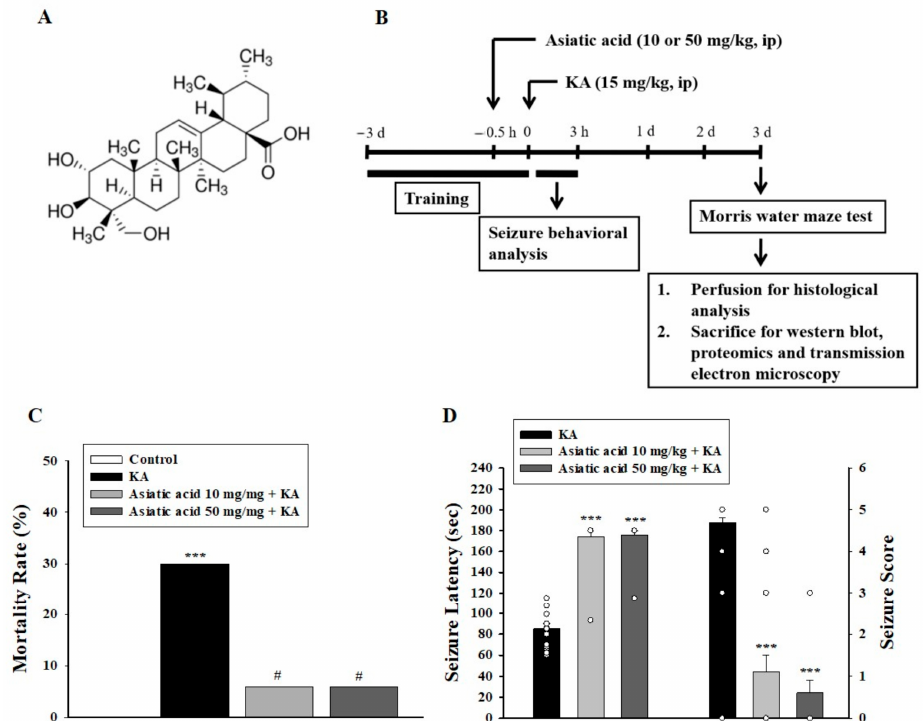
Figure 1. Asiatic acid pretreatment attenuated seizures in rats subjected to KA (kainic acid). ( A ) Chem- ical structure of asiatic acid. ( B ) Schematic timeline of the experimental protocol. ( C ) Mortality rate and ( D ) seizure latency and seizure score in the presence of asiatic acid versus the animals that were injected only with KA. *** p < 0.001 (vs. control); # p < 0.001 (asiatic acid + KA vs. KA); n = 14–20 rats per